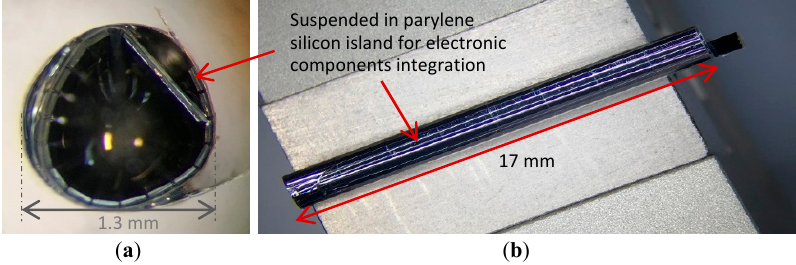
Figure 4. Photography of the 10 mm wide and 17 mm long device, with integrated various-size silicon island, wrapped into a 1.3 mm diameter needle-like shape: ( a ) Cross-section of the device with 200 µm wide small silicon islands suspended in parylene film; ( b ) Side-view of the 17 mm long needle-shape